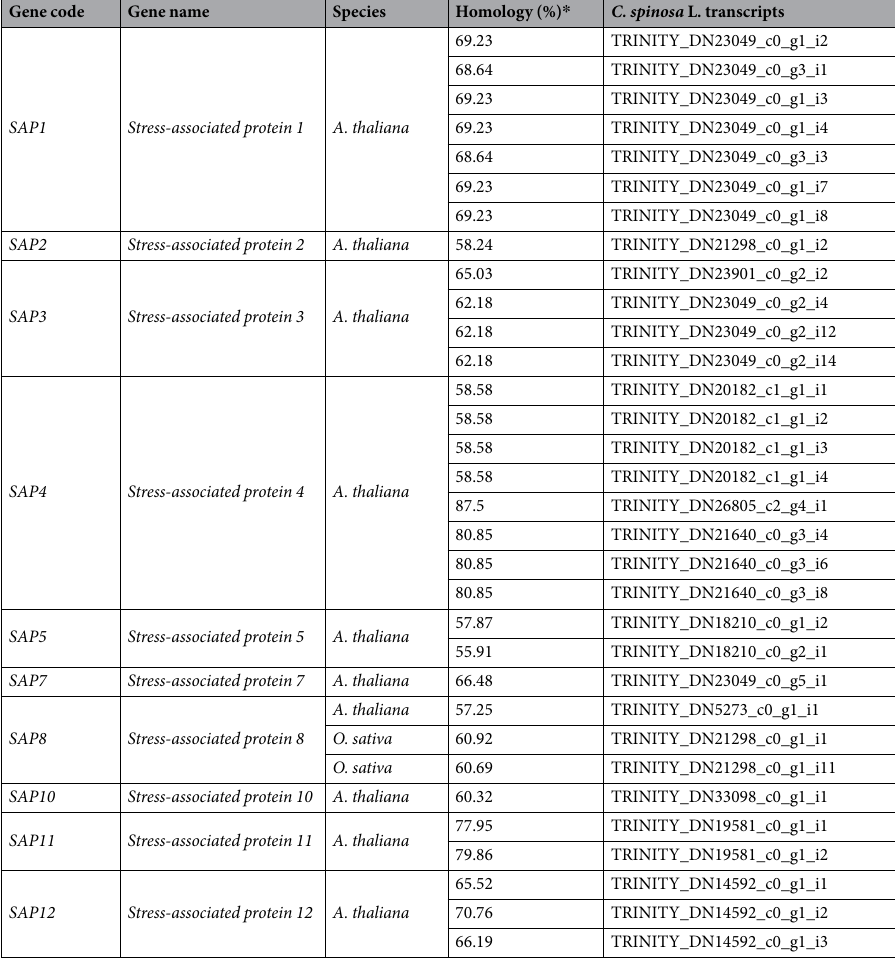
Table 3. List of Capparis spinosa leaf transcripts homologous to genes encoding for SAPs. * The homology (best hit) was obtained blasting C. spinosa transcripts to NR database.